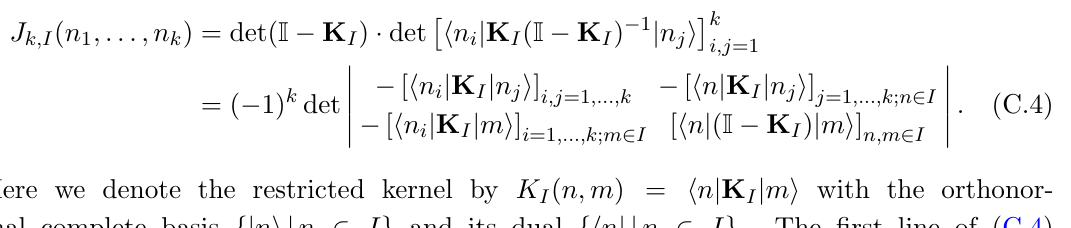
= [ K ( n; m )] on I for the I n;m 2 I